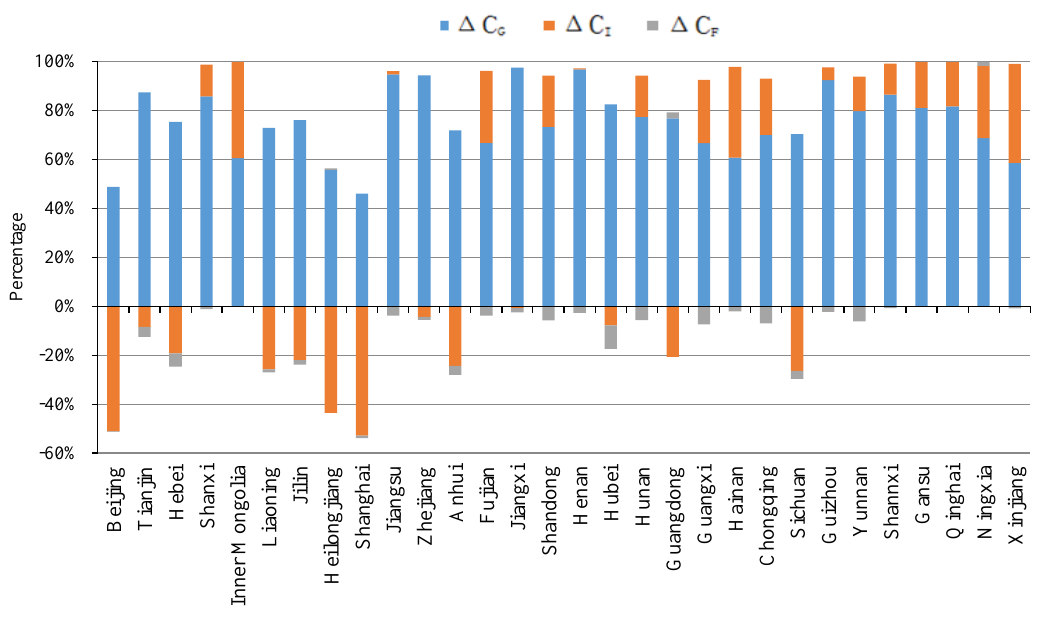
Figure 7. Decomposition of changes in CO 2 emissions across the 30 provincial power grids in China, 2000–2013 (relative terms).